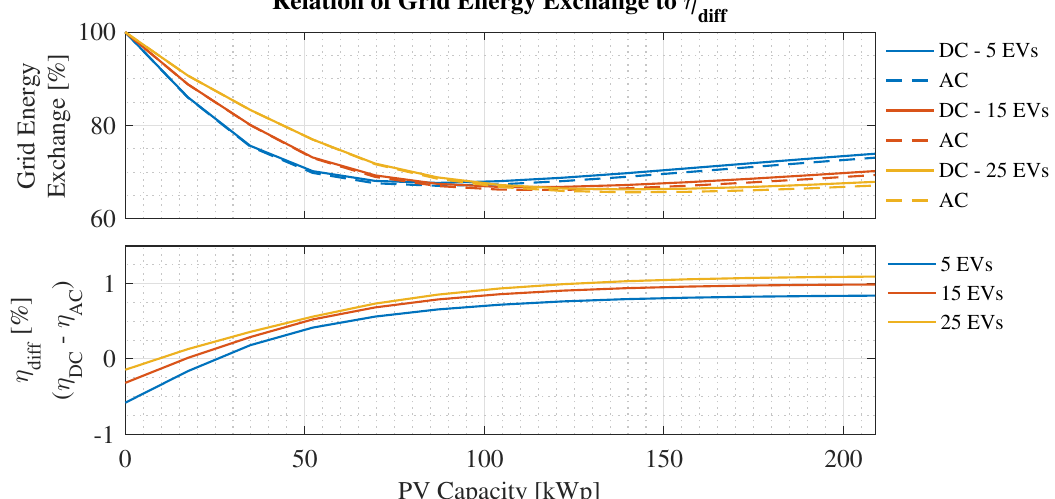
Figure 5. Correlation of grid exchange and relative